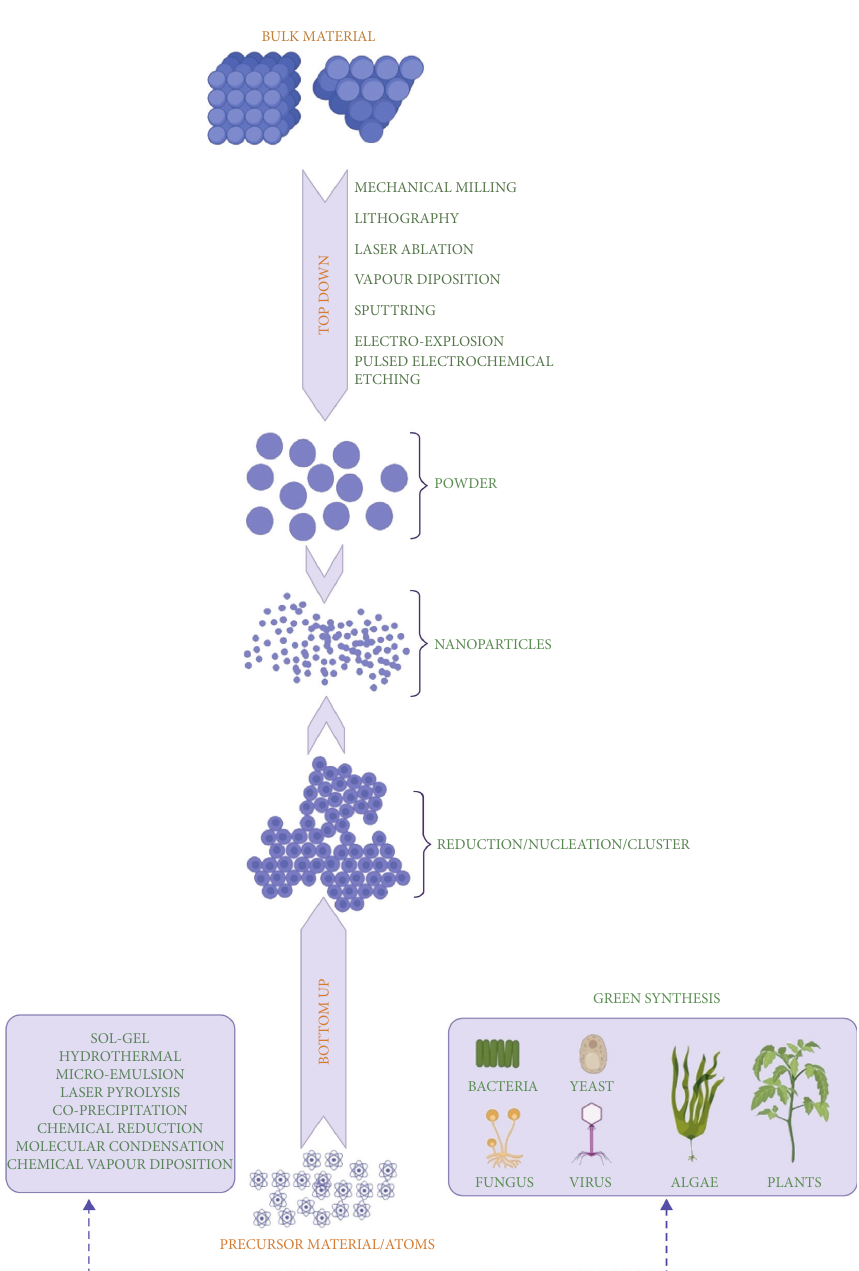
Figure 2: Schematic diagram of two fundamental approaches (top-down and bottom-up) for the synthesis of NPs. Created with BioRender. com with publication